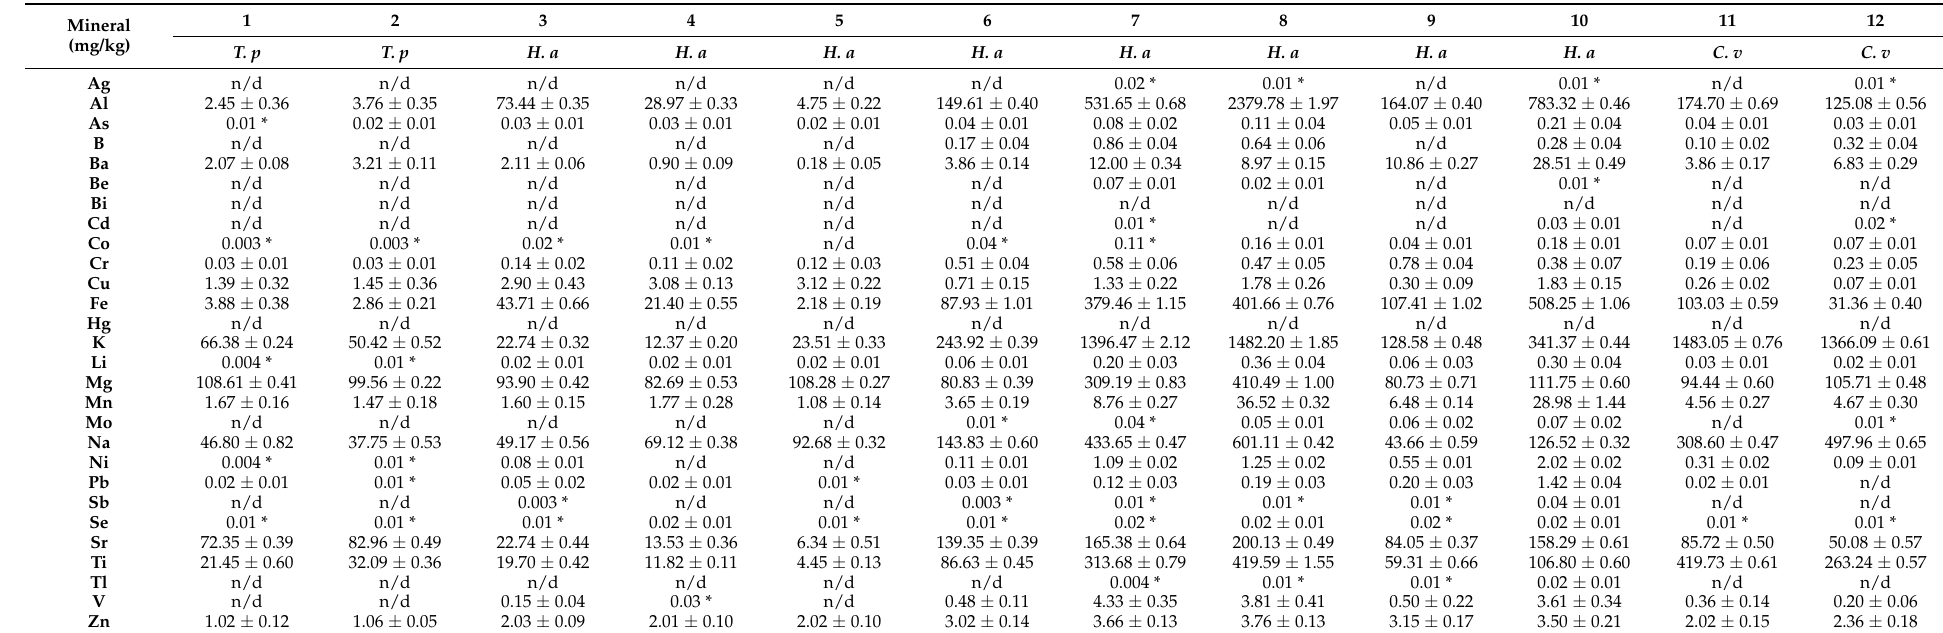
Table 4. Mineral contents in the gastropod shells samples expressed as